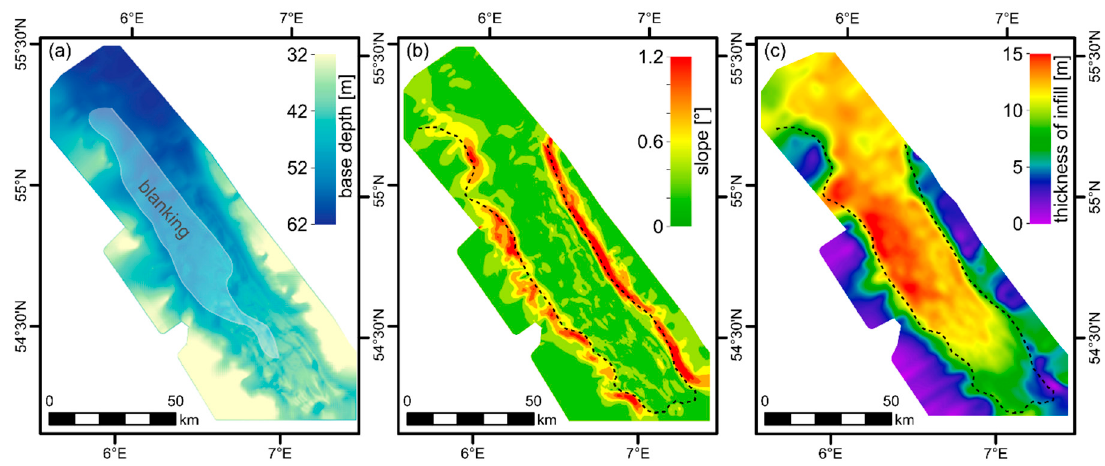
Figure 3. ( a ) Depth of the PEV below present sea level (reflector SR-A), ( b ) slope of the PEV, and ( c ) thickness of the sedimentary infill (seismic unit SU-2, 3 and 4). The dashed line represents the outline of the basin.